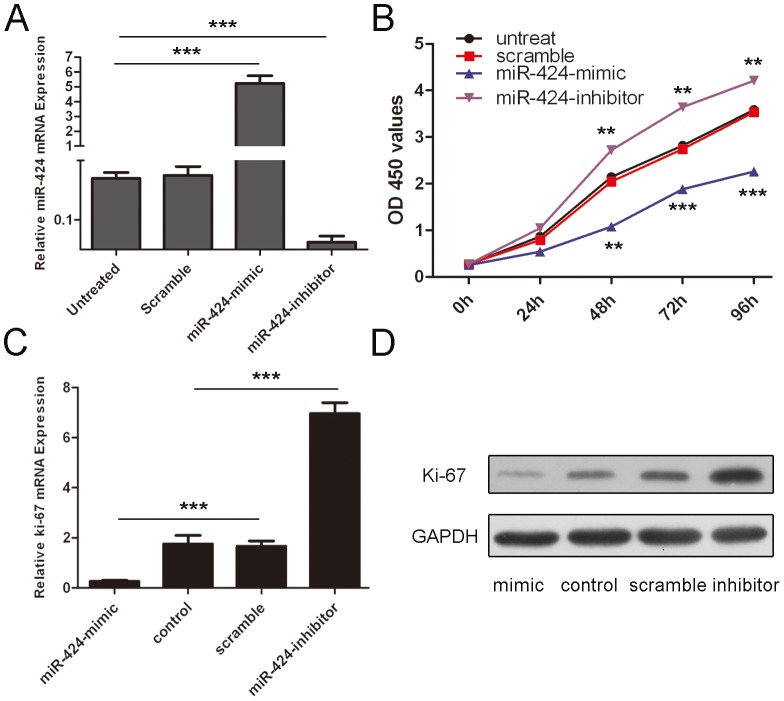
Overexpression of miR-424 inhibits the cell proliferation in HepG2.(A) qRT-PCR analysis of miR-424 expression after the transfection of miR-424 mimics, inhibitors or scramble or no transfection. (B) The CCK8 assay used to evalute the proliferation of HepG2 cells after transfection with the miR-424 mimics, inhibitors or scramble or no transfection. (C) miR-424 inhibited Ki-67 mRNA expression. HepG2 cells were transfected with miR-424 mimics, inhibitors or scramble or no transfection. Ki-67 mRNA levels were detected by real-time PCR. The expression of Ki-67 was normalized to GAPDH. (D) miR-424 inhibited Ki-67 protein expression. HepG2 cells were transfected with miR-424 mimics, inhibitors or scramble or no transfection. Ki-67 levels were detected by western blot. GAPDH was also detected as a loading control. Values are presented as the mean ± SD. Compared with control, *p<0.05, ** p<0.01, and ***p<0.001.